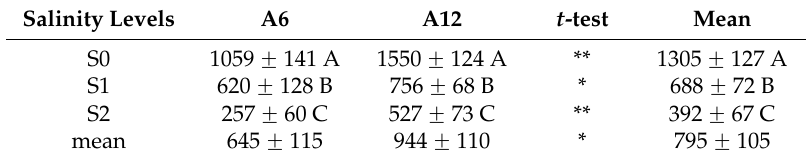
Table 4. Total biomass (mg ¨ plant ´ 1 on dry weight) in response to different salinity